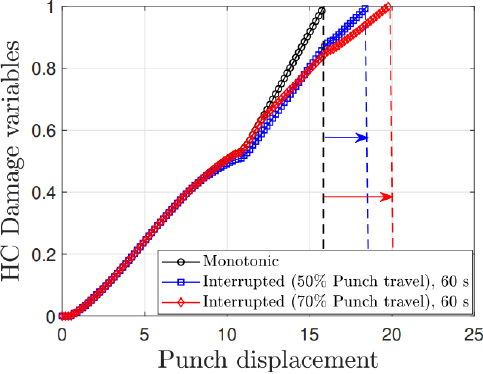
Fig. 14 Evolution of HC damage variables in monotonic and interrupted HET with punch displacement (the respective arrows indicate the delay in damage variables due to interrupted